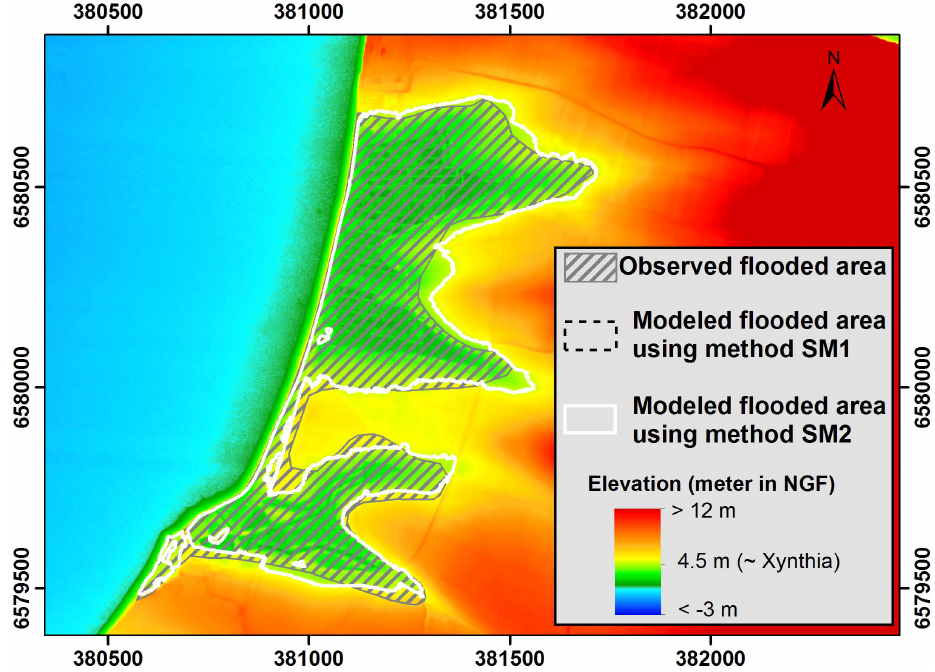
Fig. 7. Digital Terrain Model (DTM) of the Coup de Vague Marsh (no. 8) showing the observed flooded area (hatched grey lines), the modeled flooded area using method SM1 (black dotted line) and the modeled flooded area using method SM2 (white